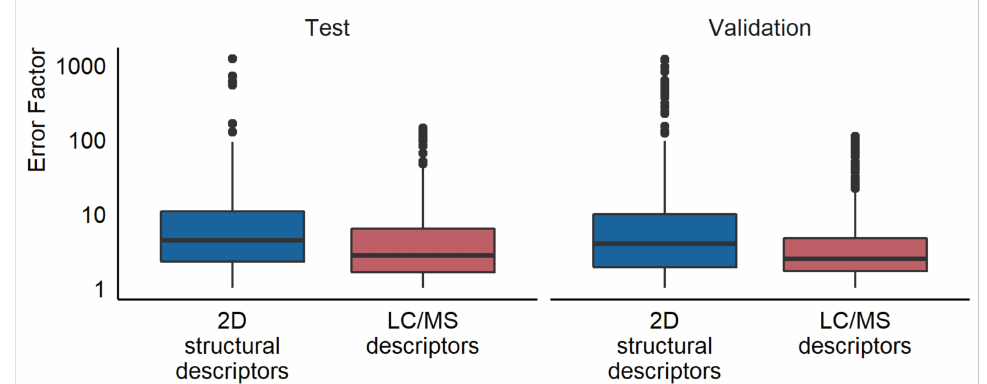
Figure 3. A box plot showing the prediction error for the test and validation set using the random forest LC/MS descriptors models and the 2D structural descriptors models developed by Liigand et al.